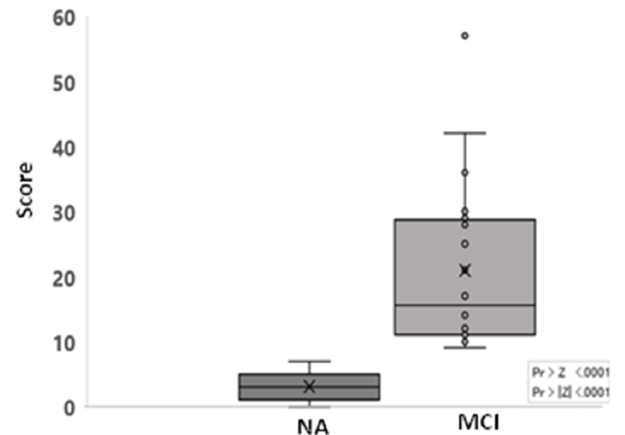
Figure 2. Score of the CCAS according to the cognitive impairment. Normal ageing (NA, n = 75); Mild/Moderate Cognitive Impairment (MCI, n = 25). Mild/Moderate Cognitive Impairment (MCI, n =